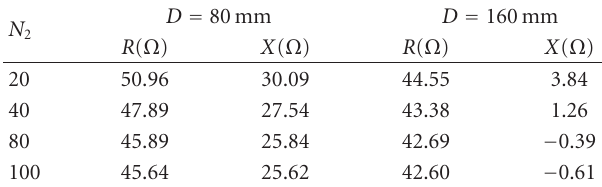
Table 1: Convergence behavior of the self-impedance result of the monopole antenna with respect to N 1 , the truncation number of the modal expansion in Region III ( f = 0 . 9375GHz, N 2 = 80).